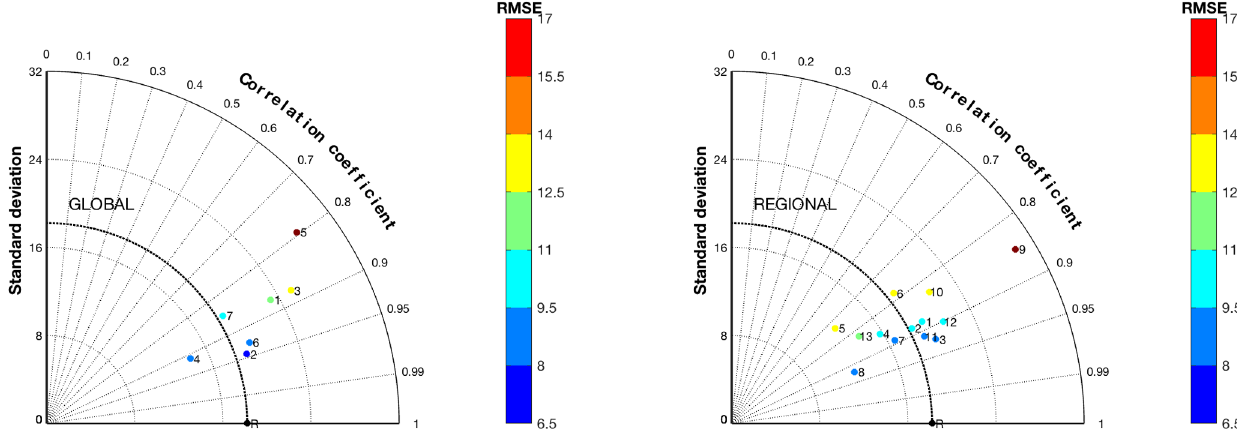
Figure 2. Taylor diagram of global models and regional models.